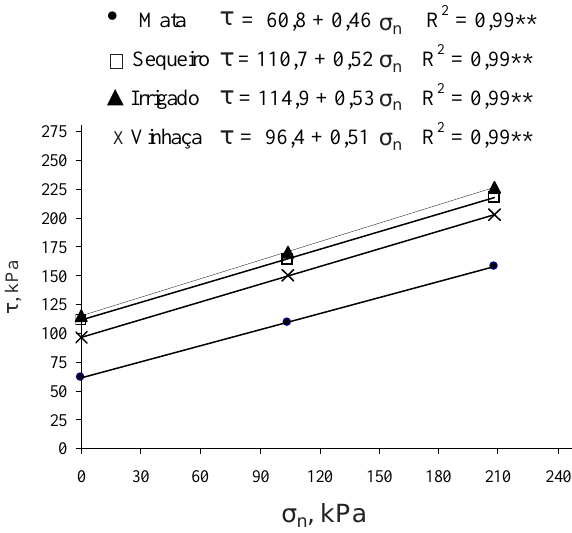
Figura 6. Resistência ao cisalhamento ( τττττ ) de acordo com a tensão normal ( σσσσσ ) na camada de 0,4– n 0,8 m e teor de água de 0,11 kg kg -1 para os sistemas de manejo estudados.